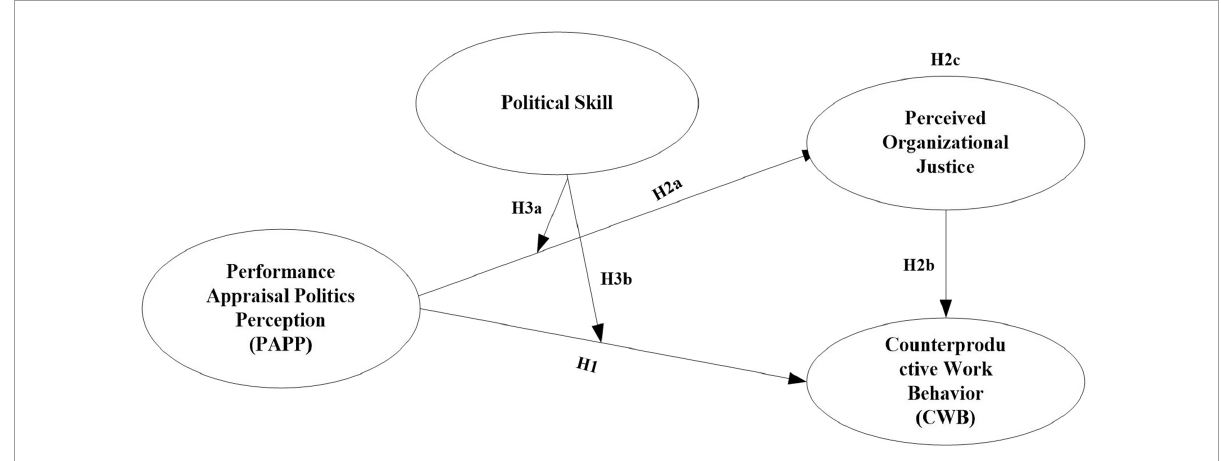
FIGURE1 The theoretical hypothesis